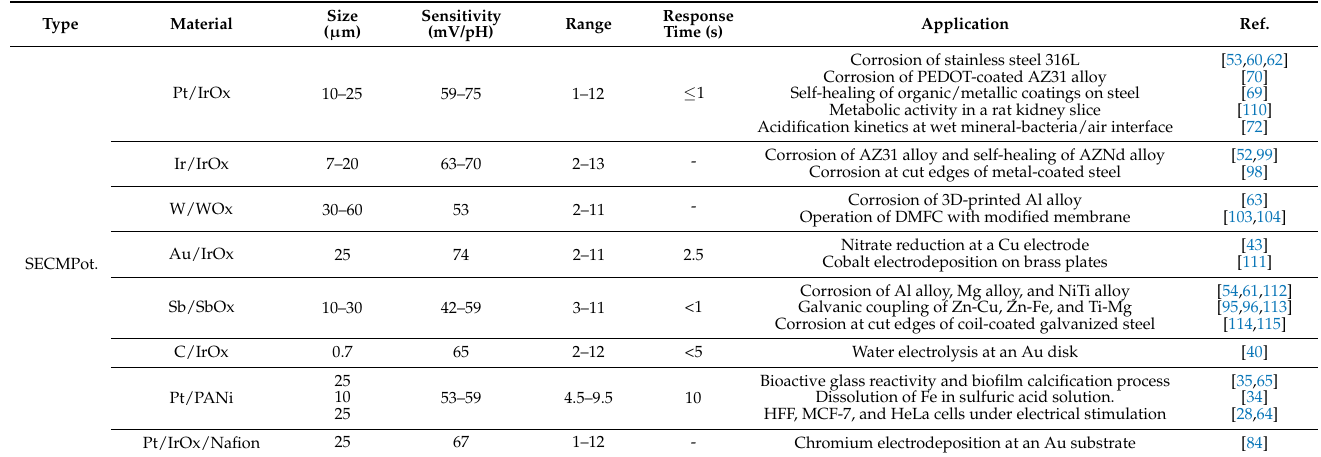
Table 1. Summary of micro/nanoprobe pH sensors with their parameters/characteristics and respec- tive